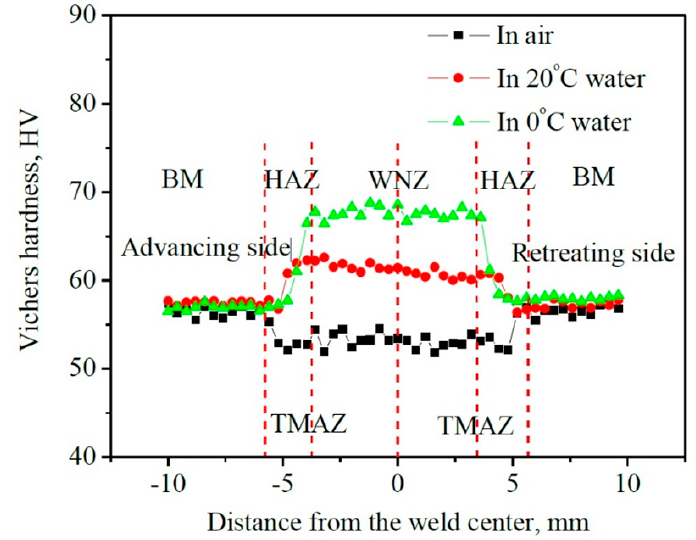
Figure 21. Hardness distribution profiles on the surface of the welded samples for as-received hot bands of AA3003 Al alloy welded under different welding ambient conditions [59]. Reprinted from: A study on microstructure and mechanical properties of AA 3003 aluminum alloy joints by underwater friction stir welding. Materials Characterization 127 (2017): 41–52, Tan, Y. B., X. M. Wang, M. Ma, J. X. Zhang, W. C. Liu, R. D. Fu, and S. Xiang, Copyright 2017, with permission from Elsevier.